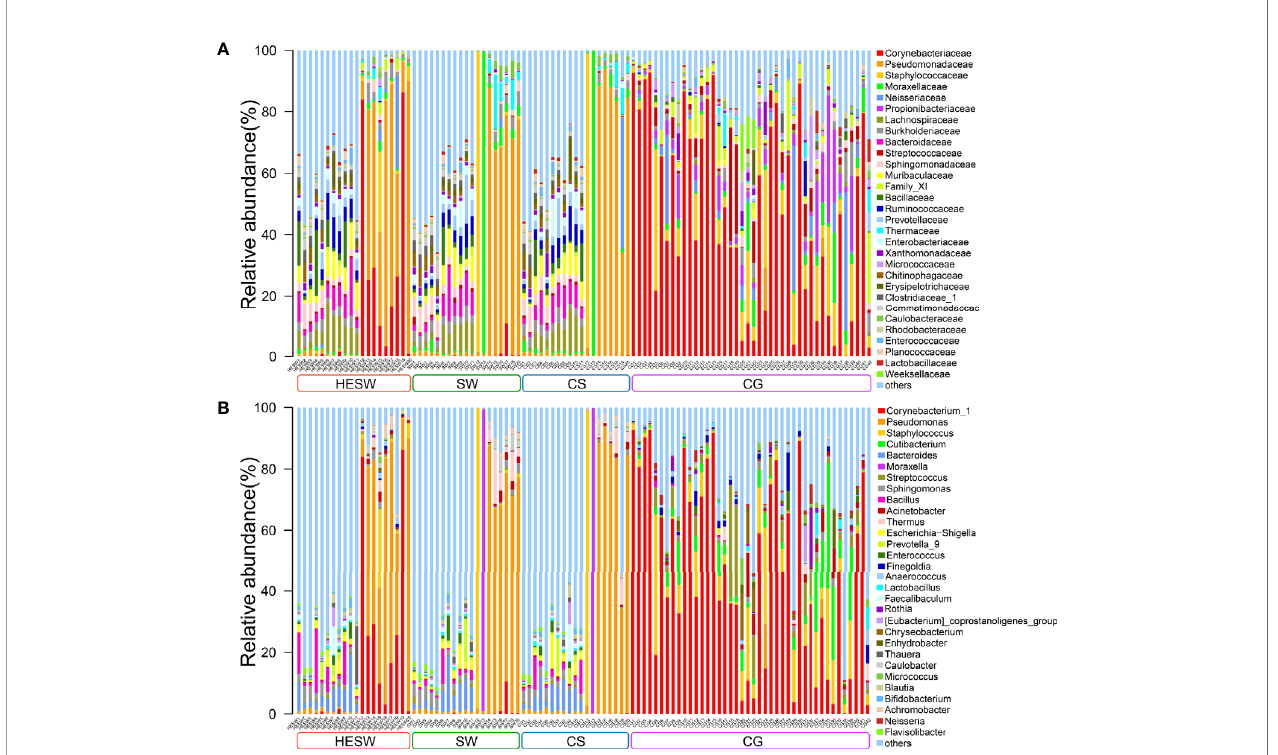
FIGURE 1 | The relative composition of ocular microbiota. Each bar represents a sample of conjunctival microbiota, various color portions represent different genera, and the length of a colored portion represents the relative content of a family (A) or genus (B) . Among the 102 samples, 100 positive samples were obtained, including 20 conjunctival swabs from the healthy eyes of patients with bacterial keratitis (BK) (group HESW), 19 conjunctival swabs from the diseased eyes of BK patients (group SW), 19 corneal scrapings from the diseased eyes of BK patients (group CS), and 42 conjunctival swabs from the healthy volunteers (group CG). Different samples possess diverse ocular surface